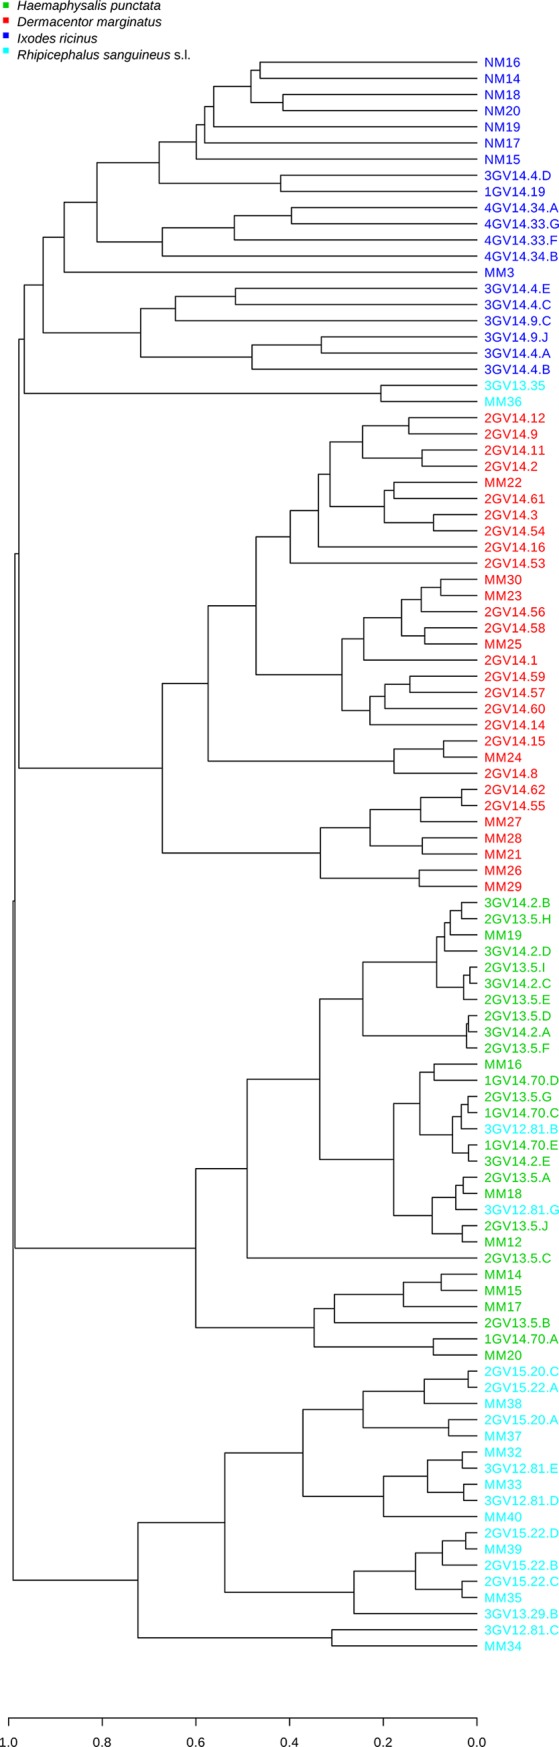
Cluster dendrogram generated among samples at OTU level using Bray Curtis distance index.